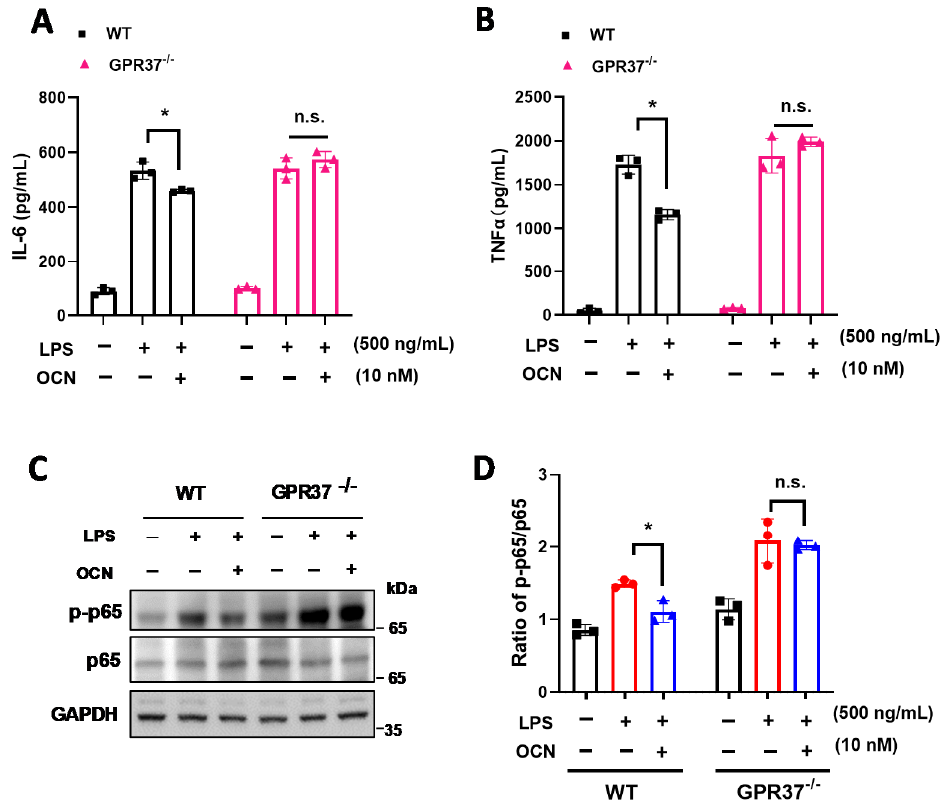
Figure 4. GPR37 mediates the inhibitory effects of OCN on pro-inflammatory factors in macrophage. ( A , B ) Cytokine levels in the culture medium of peritoneal macrophages from WT and GPR37 − / − mice. Cells were treated with LPS (500 ng/mL, 37 °C, 24 h) together with PBS or OCN (10 nM). ELISA analysis was performed to measure the level of IL-6 ( A ) and TNF- α ( B ). Data are presented as mean ± SD ( n = 3 biological replicates), * p < 0.05, as compared to PBS, and n.s. indicates not significant. ( C , D ) Representative immunoblot images ( C ) and quantitative analysis ( D ) of NF κ B p65 level in macrophages treated with LPS in the presence of OCN. Data are presented as mean ± SD ( n = 3 biological replicates), * p < 0.05 as compared to PBS, and n.s. indicates not significant.